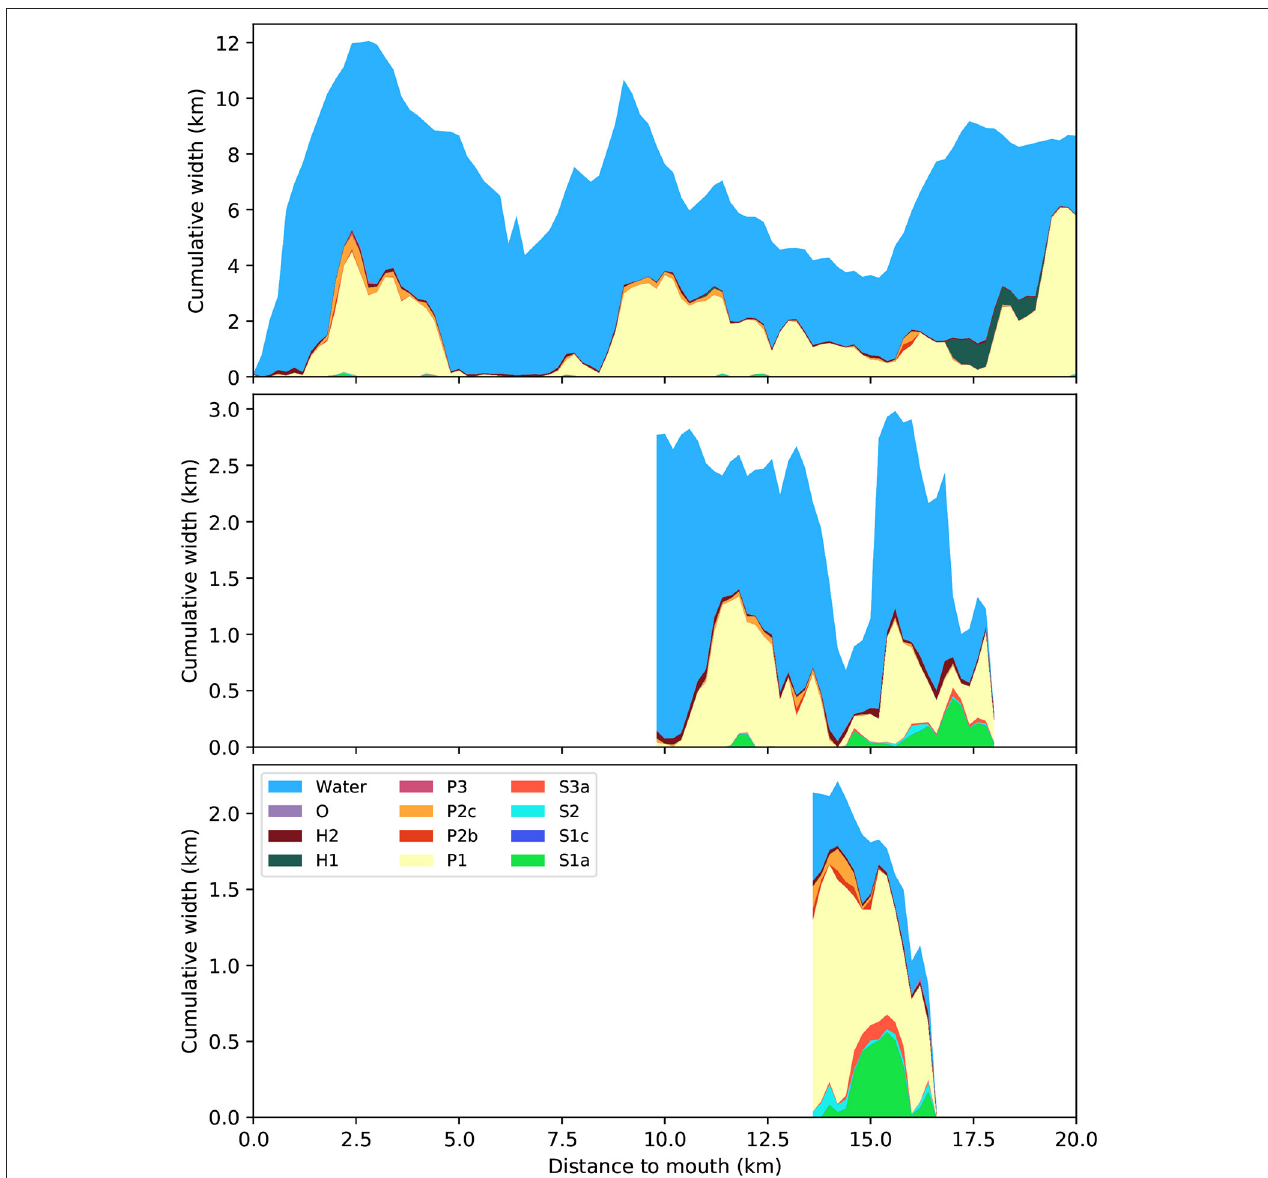
FIGURE 6 | Distribution of biogeomorphological classes separately plotted as cumulative width for the main branch (top) and two side branches of the Eastern Scheldt, one with a SW-NE orientation (middle) , and the small W-E channel ( bottom, middle channel in Figure 1 ). The sum of the branches is plotted in Figure 5 (middle) . Distance is measured along a centerline from the narrowest cross-section in the seaward mouth. For explanation of legend see Table 2 .